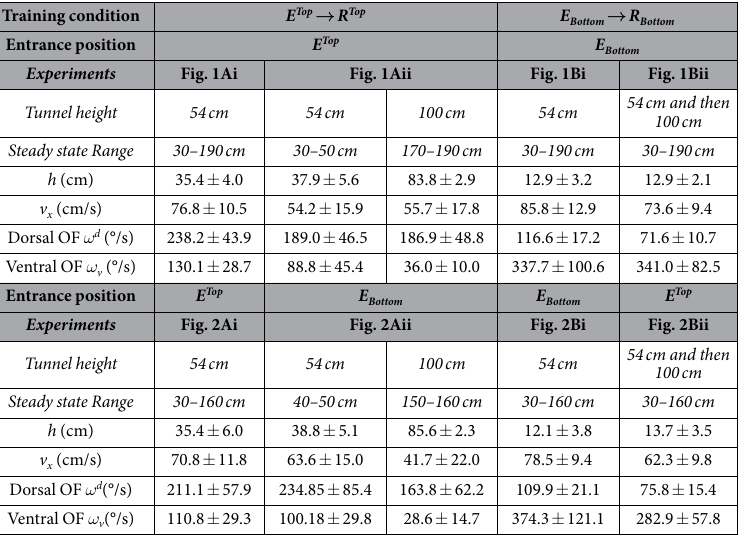
Table 1. Horizontal speed v x , height of flight h and the dorsal ω d and ventral ω v optic flow (OF) (Median ± MAD -Median Absolute Deviation-) experienced by honeybees during the steady flight height phase while flying along the tunnel in the various experimental